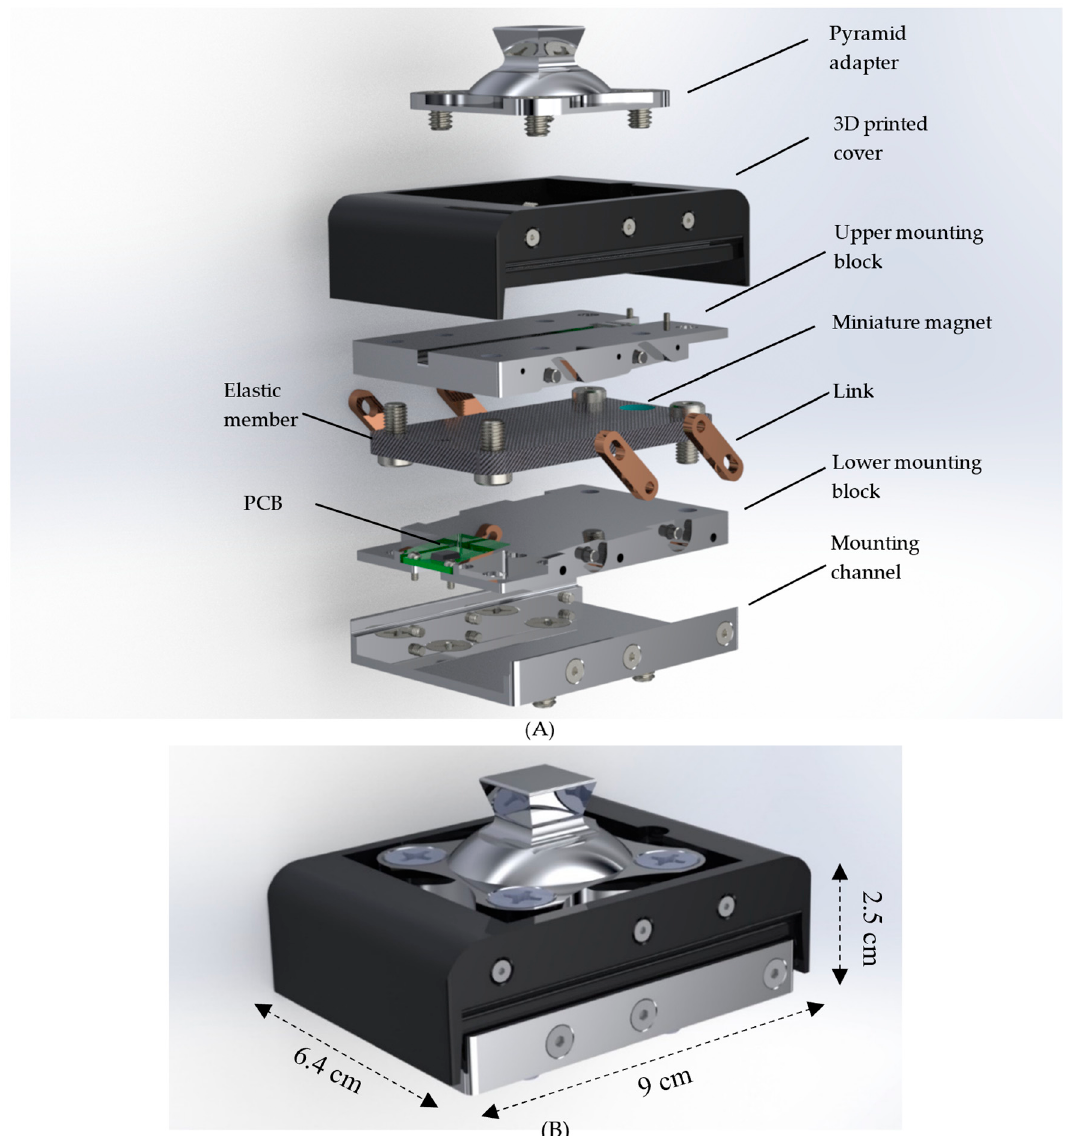
Figure 4. Detail design of the FM-PLS sensor: ( A ) Exploded view, and ( B ) FM-PLS sensor with dimensions .